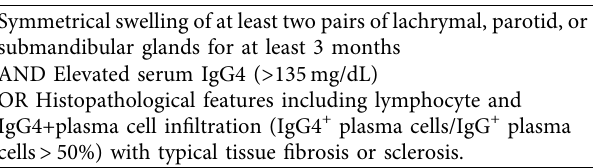
Table 3: Diagnostic criteria of IgG4 + mikulicz’s disease (approved by the Japanese Society for Sj¨ogren’s Syndrome 2008) [131]. Symmetrical swelling of at least two pairs of lachrymal, parotid, or submandibular glands for at least 3 months AND Elevated serum IgG4 ( > 135 mg/dL) OR Histopathological features including lymphocyte and IgG4+plasma cell infiltration (IgG4 + plasma cells/IgG + plasma cells > 50%) with typical tissue fibrosis or